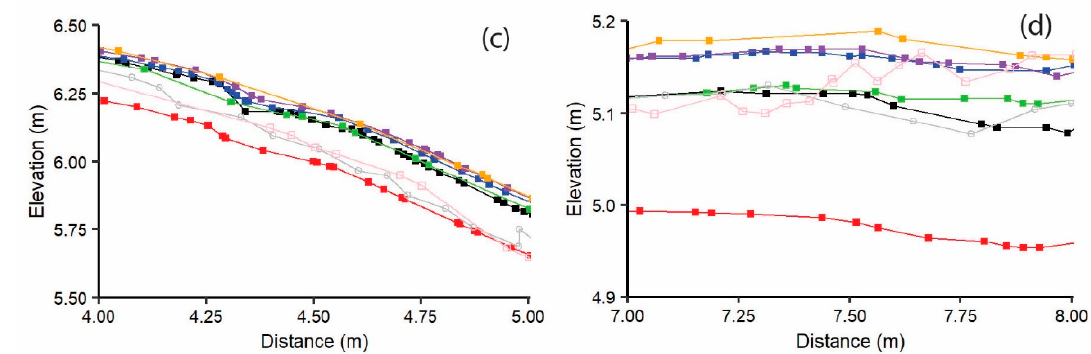
Figure 9. Smaller segments of vertical profiles of all dense clouds classified as ground for the rough terrain where segments ( a , c ) are rocky steps and segments ( b , d ) are pools of sand. All points that intersected the profile line were extracted from each point cloud. The lines represent connection of adjacent points.